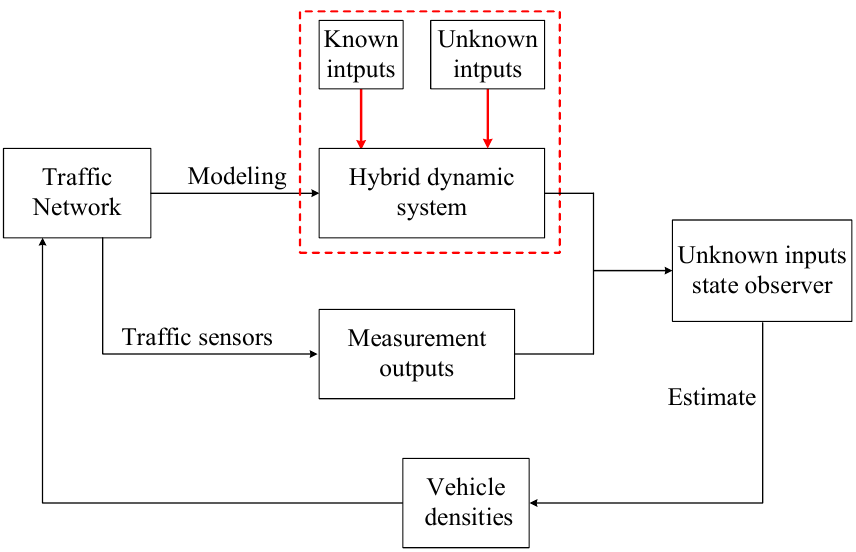
Figure 1. An overview of the proposed method.